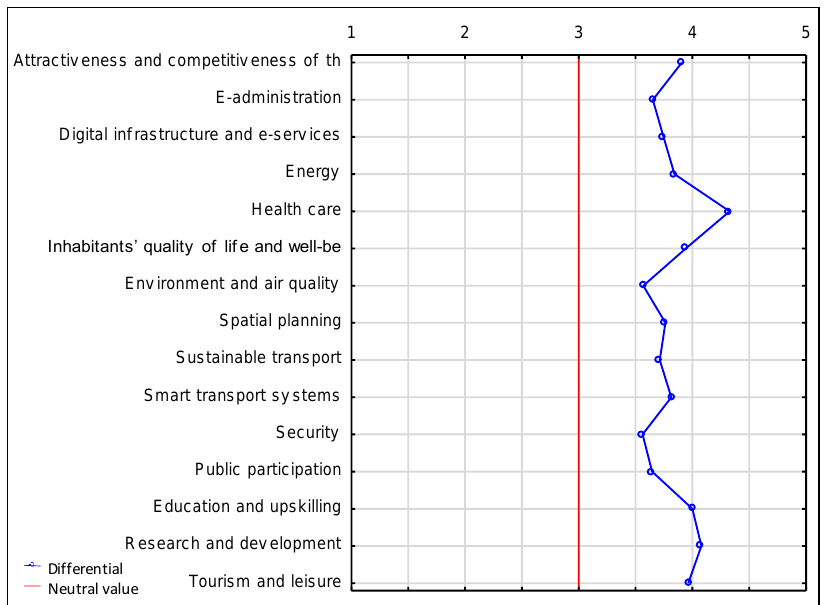
Figure 13. Semantic differential representing the necessity of introducing changes in individual aspects of the functioning of the city of Suwałki. Source: own study based on questionnaire surveys. The semantic differential graph shows that the highest demand for change comes from respondents aged 46 – 64, while women are the dominant gender group (Figure 14).